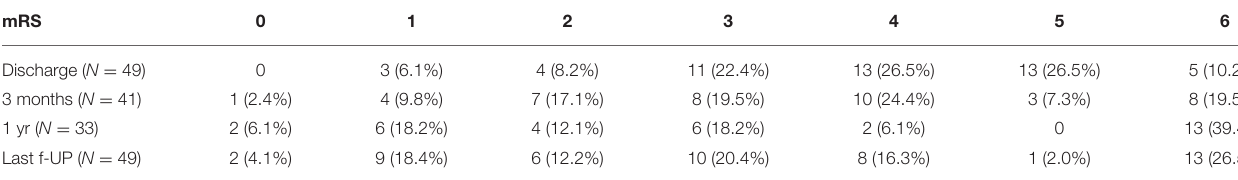
TABLE 3 | Functional outcomes after surgery over time.